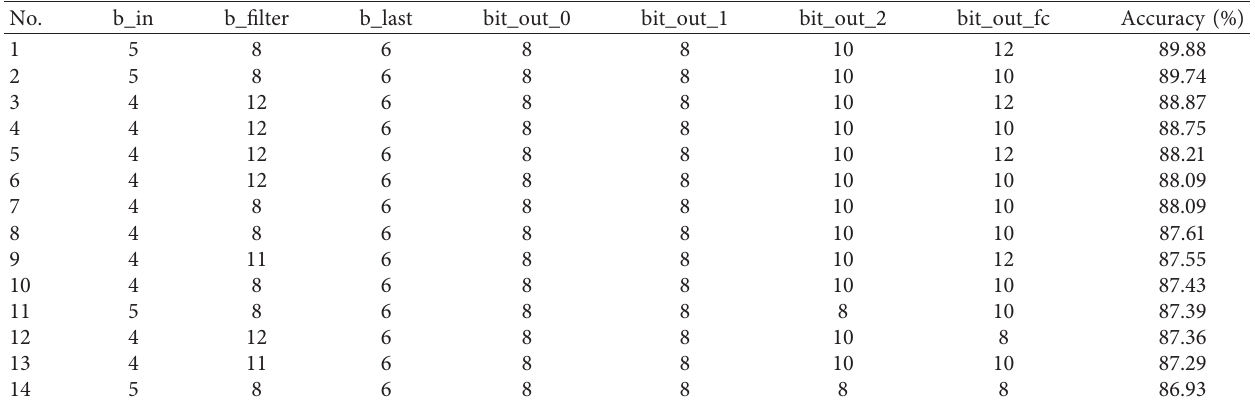
Table 3: Results of the second quantization